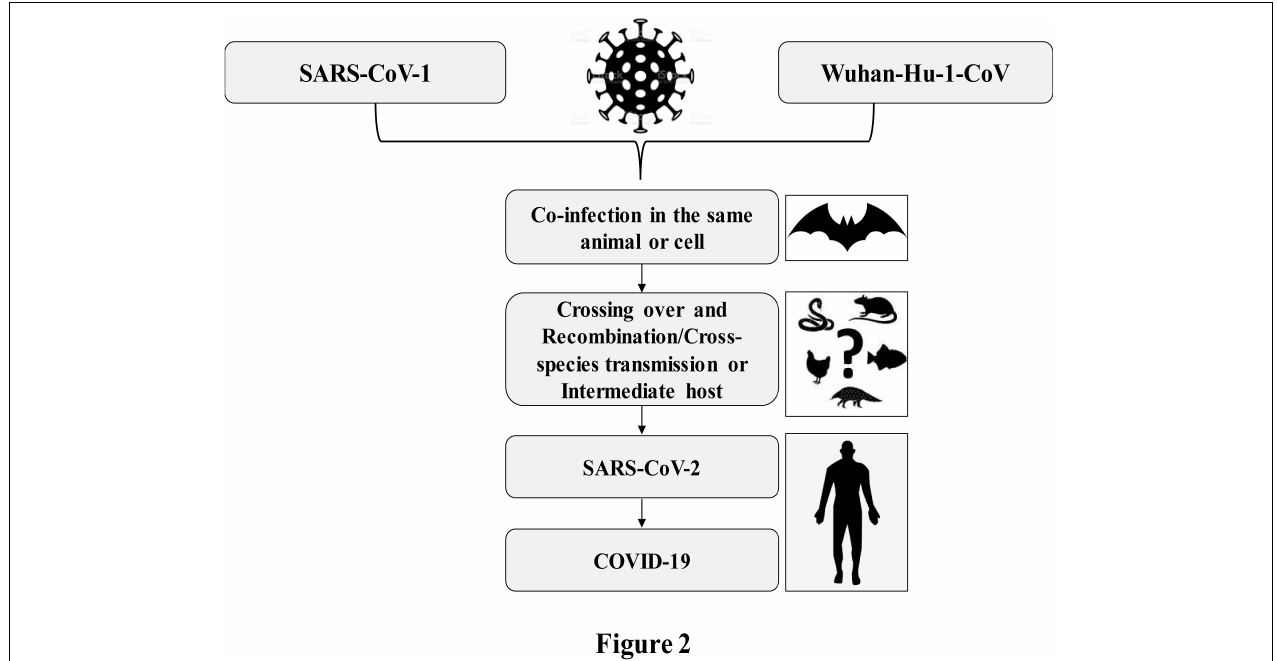
FIGURE 2 | Crossing over due to coinfection and possible recombination of SARS-CoV-2 causing COVID-19.